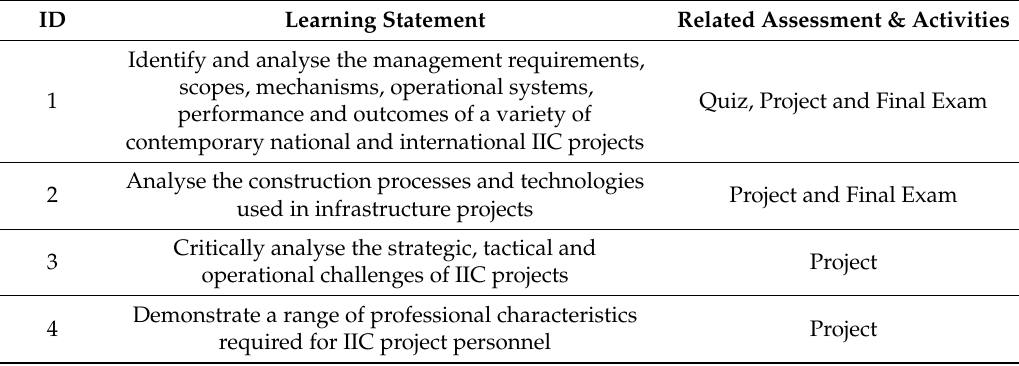
Table 3. Selected course learning outcomes for the chosen course about infrastructure